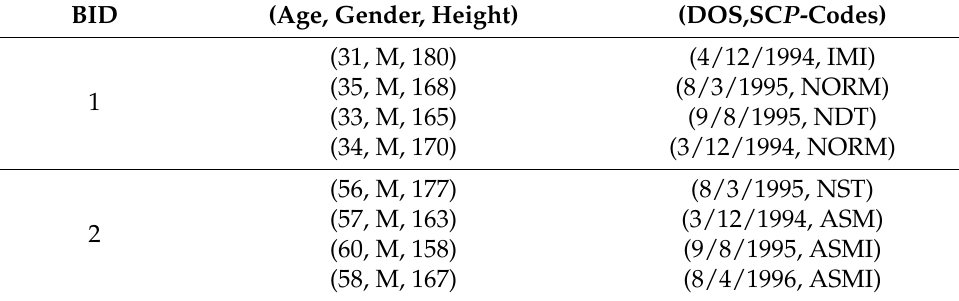
Table 9. Sensitive attributes of males’ data.